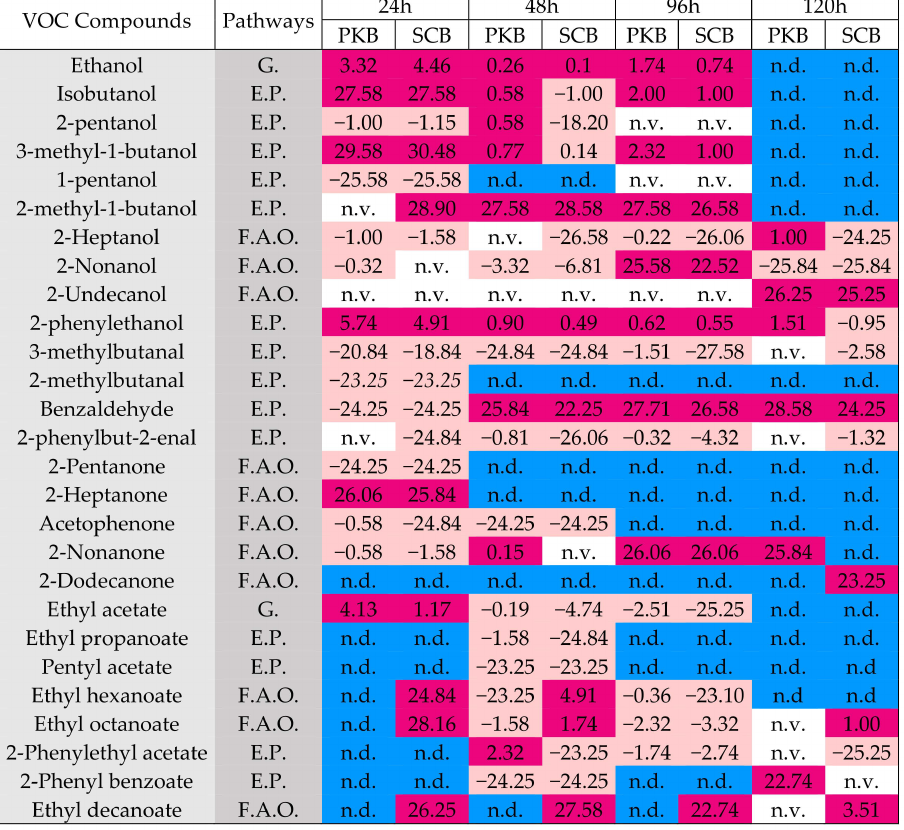
Figure 4. Combination of charts showing altered volatile organic compounds (VOCs) and addressed microbiota metabolic pathways, where numbers inside boxes display the base 2 logarithms of fold-change calculated with respect to the response in uninoculated samples; blue color (n.d.) = not detected during fermentation in all batches; white color (n.v.) = no variation with respect to control; red color (+) = increase after addition of the strains; pink color ( − ) = decrease after addition of the strains. Pathways: F.A.O.: Fatty Acids Oxidation. G.: Glycolysis. E.P.: Ehrlich